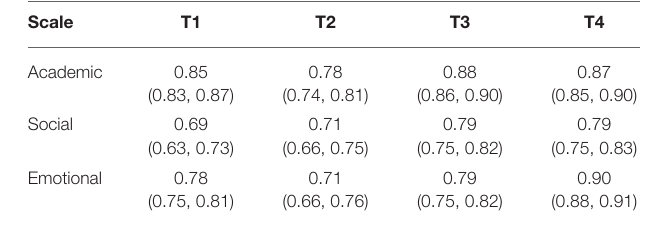
TABLE 3 | Omega point estimates and confidence intervals for self-efficacy scores at all-time points.